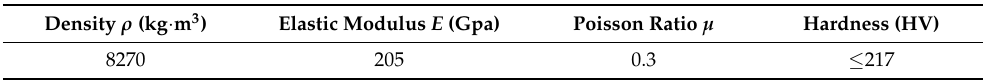
Table 2. Basic physical properties of